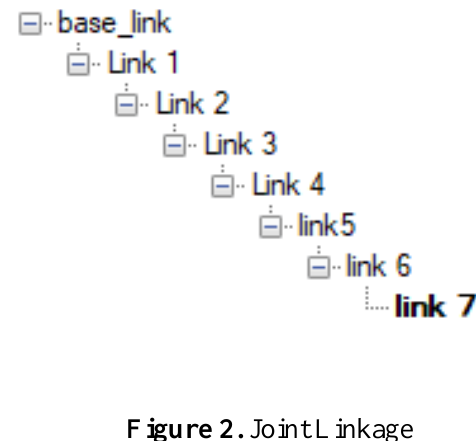
Figure 2. Joint Linkage